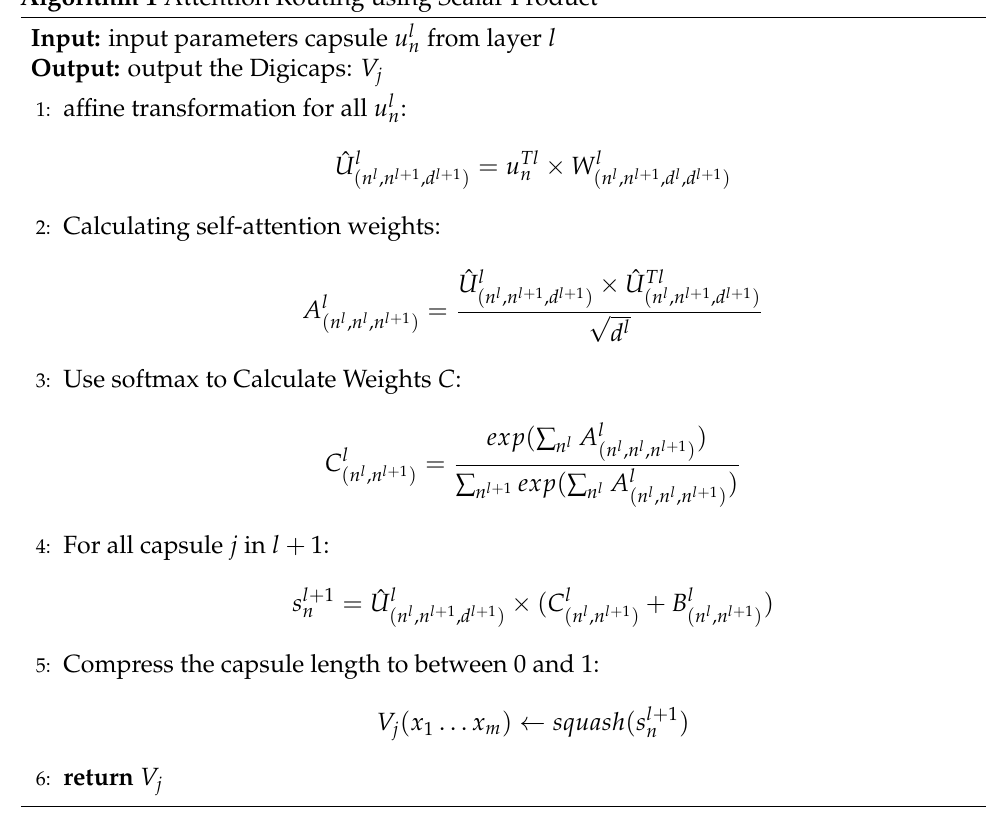
Algorithm 1 Attention Routing using Scalar Product